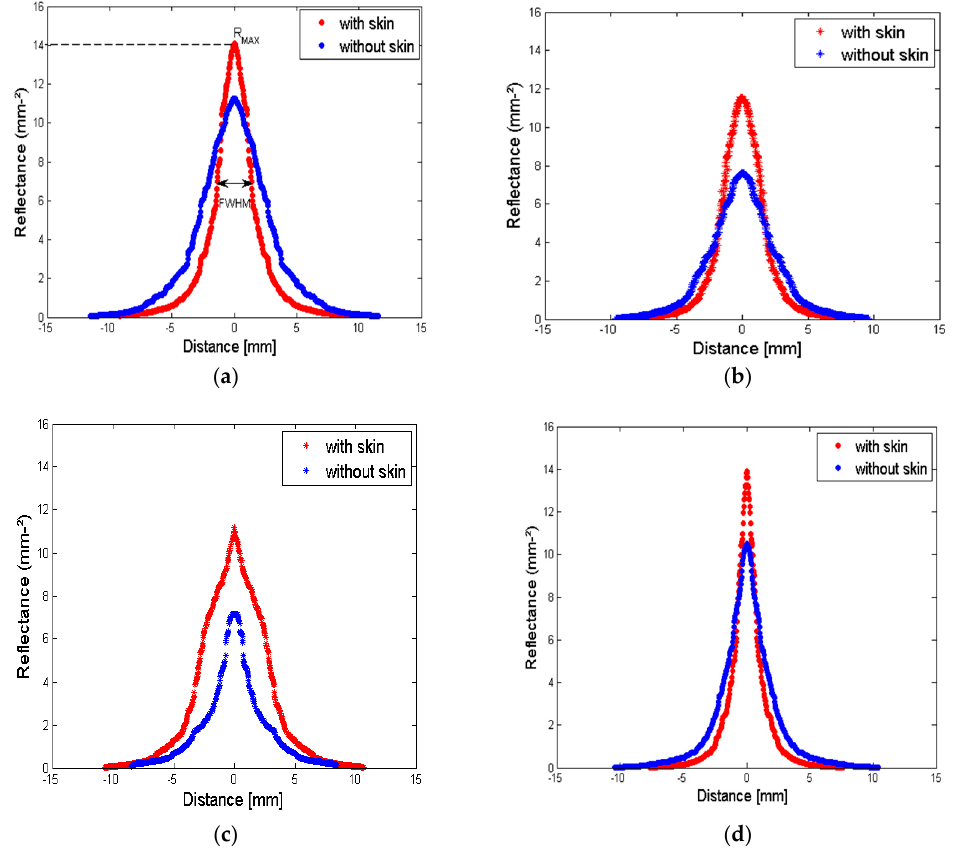
Figure 4. Reflectance profiles acquired on apple samples with and without skin. ( a ) Granny Smith at 633 nm; ( b ) Golden Delicious at 763 nm; ( c ) Royal Gala at 784 nm; and ( d ) Granny Smith at 852 nm.